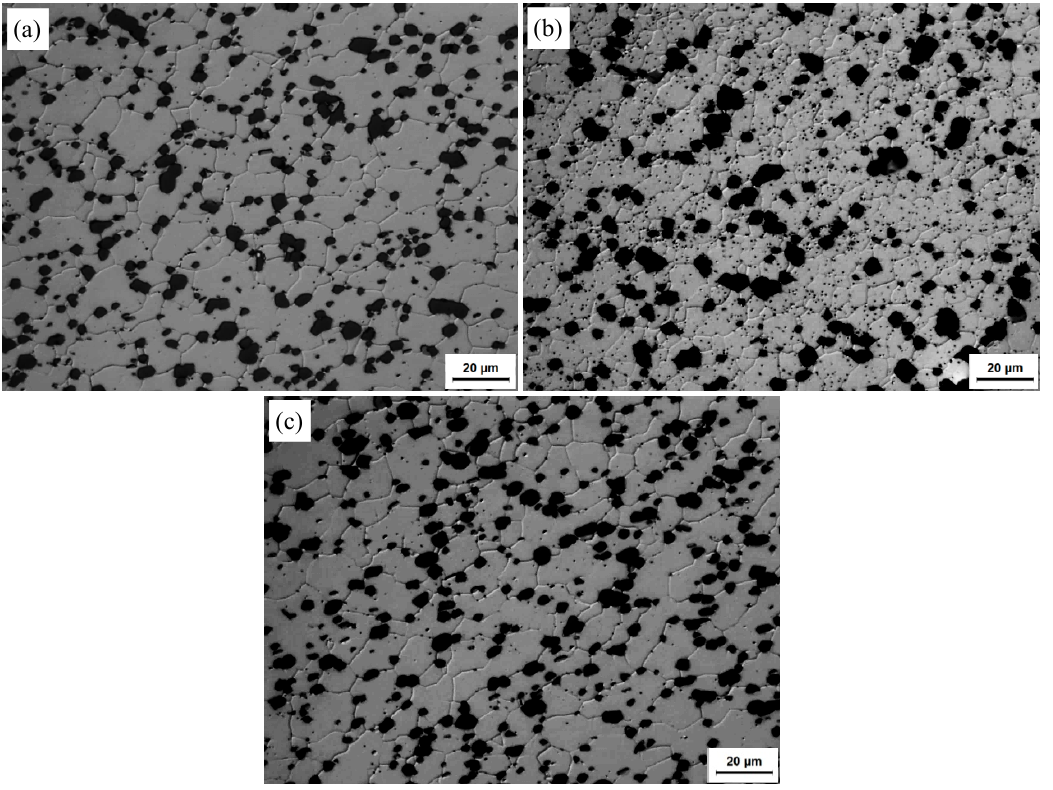
Figure 6. Optical micrographs at the nugget zones (NZs) of FSW joints under different states: ( a ) T1; ( b ) T4; ( c ) T6.